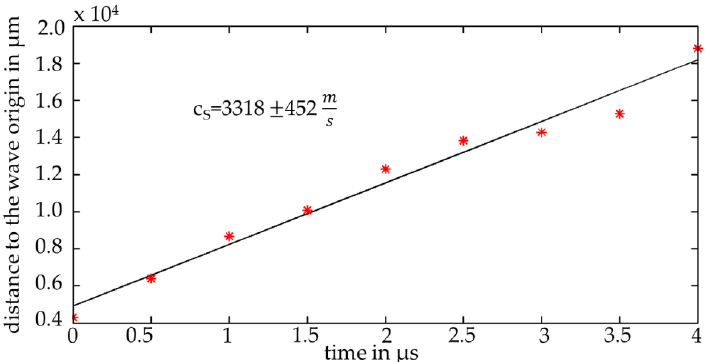
Figure 13. Velocity of propagation of the strain front, calculated from the displacement of the strain maximum (black and white dashed lines in Figure 12).